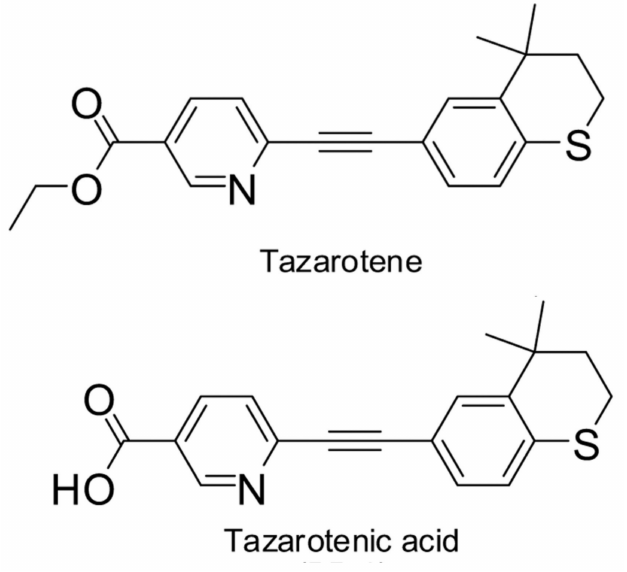
Figure 1. Structure of the tazarotene and its main degradation product, tazarotenic